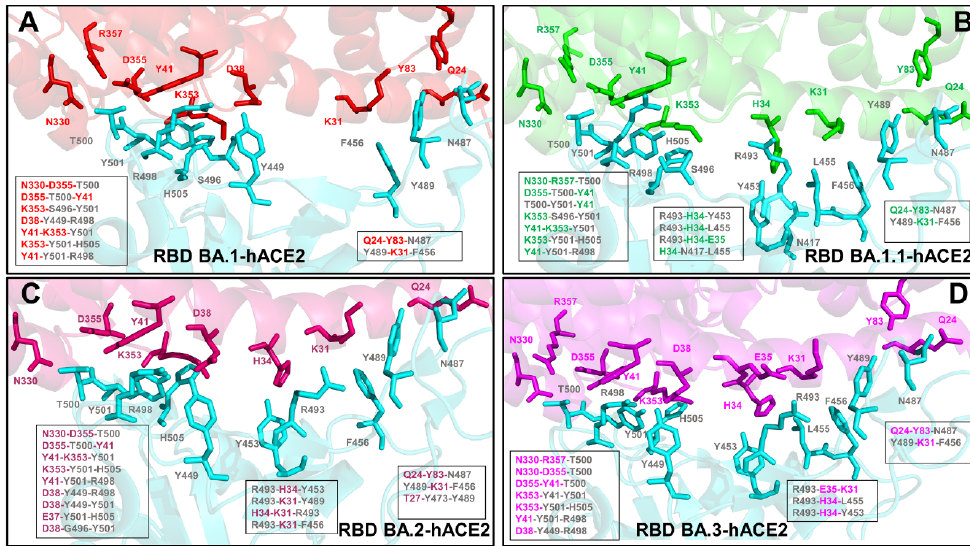
Figure 9. The network-based community analysis to infer potential epistatic relationships between S-RBD residues. The distributions of stable 3-clique communities formed at the binding interface of the Omicron RBD complexes with hACE2. Structural mapping and full annotation of the intermo- lecular cliques for the RBD BA.1-hACE2 complex. The RBD binding residues are shown in cyan sticks and the hACE2 binding residues are in red sticks ( A ). Structural mapping and annotation of the intermolecular cliques for the RBD BA.1.1-hACE2 complex. The RBD binding residues are shown in cyan sticks and the hACE2 binding residues are in green sticks ( B ). Structural mapping and full anno- tation of the intermolecular cliques for the RBD BA.2-hACE2 complex. The RBD binding residues are shown in cyan sticks and the hACE2 binding residues are in pink sticks ( C ). Structural mapping and full annotation of the intermolecular cliques for the RBD BA.3-hACE2 complex. The RBD binding residues are shown in cyan sticks and the hACE2 binding residues are in purple sticks ( D